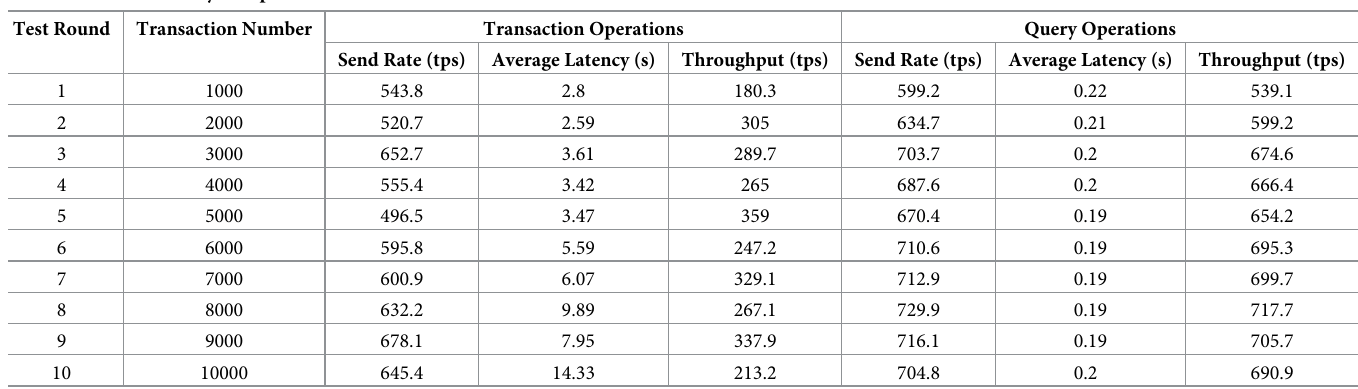
Table 8. Results of the system performance limits.